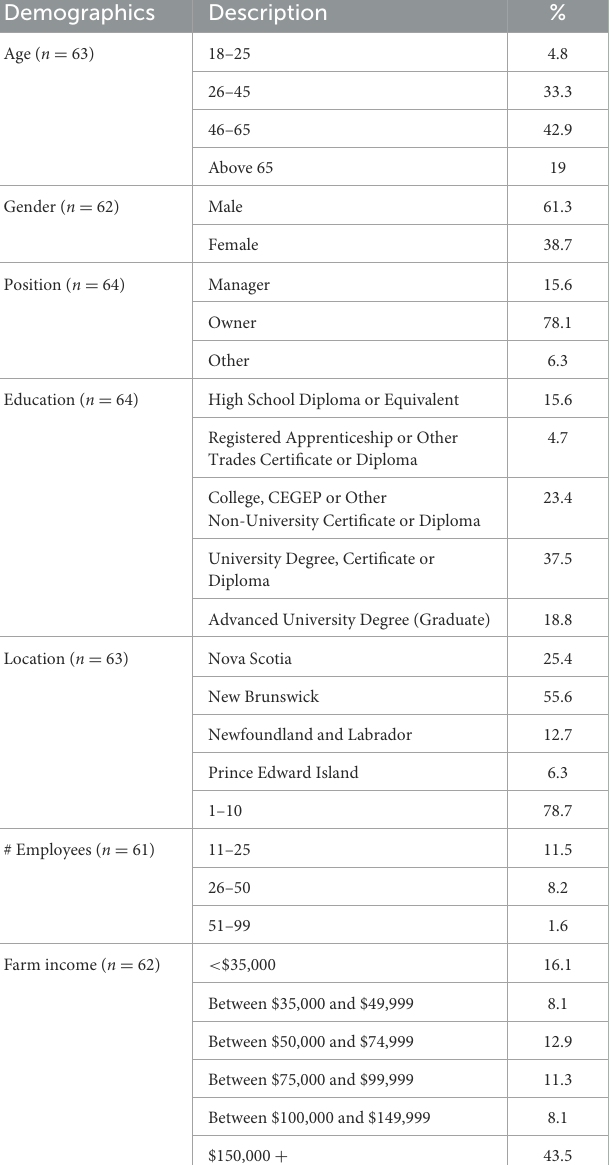
TABLE 1 Sociodemographic characteristics of study participants. TABLE 2 Summary of production and distribution systems in Atlantic Canada